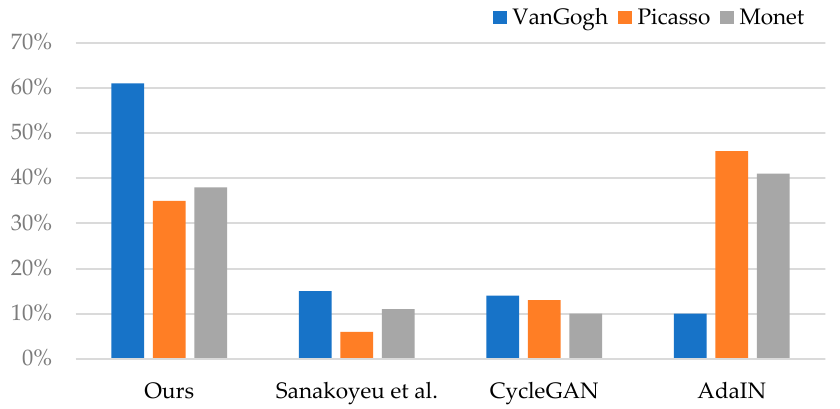
Figure 12. Comparison of user votes between methods.